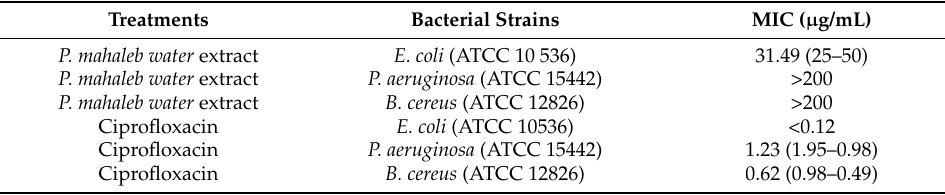
Figure 7. Null effect of Prunus mahaleb L. water extract (10–1000 µ g/mL) on human colon cancer HCT116 cell viability. Table 3. Antibacterial effects by P. mahaleb water